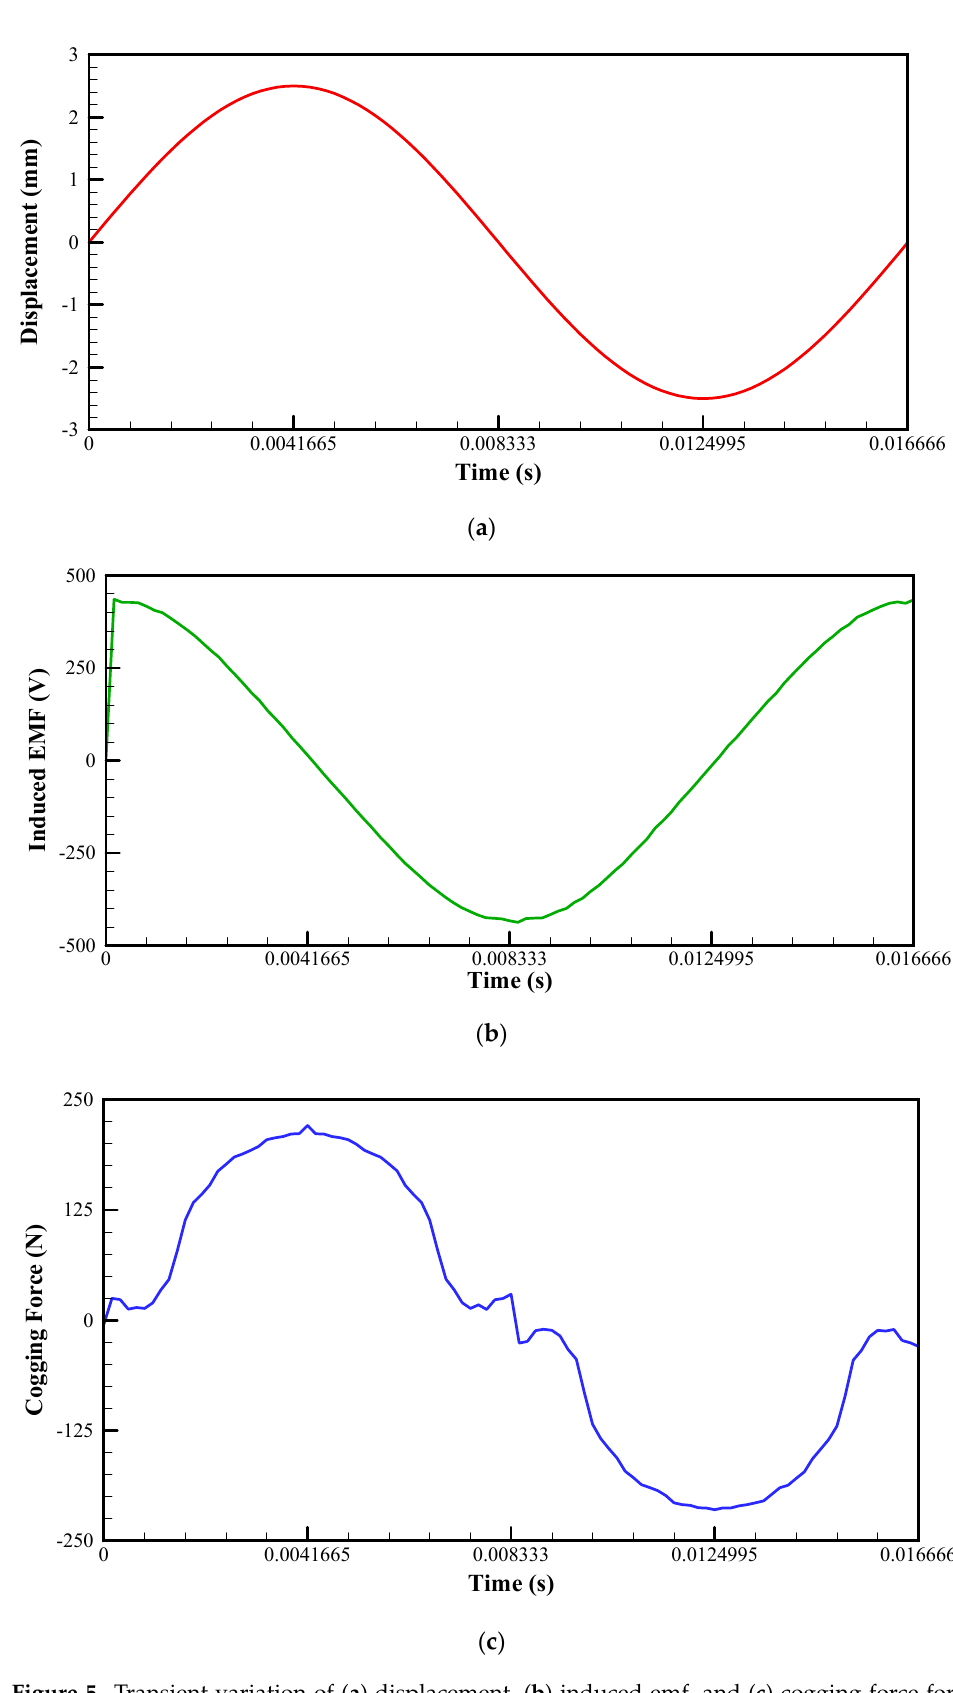
Figure 5. Transient variation of ( a ) displacement, ( b ) induced emf, and ( c ) cogging force for the baseline case.